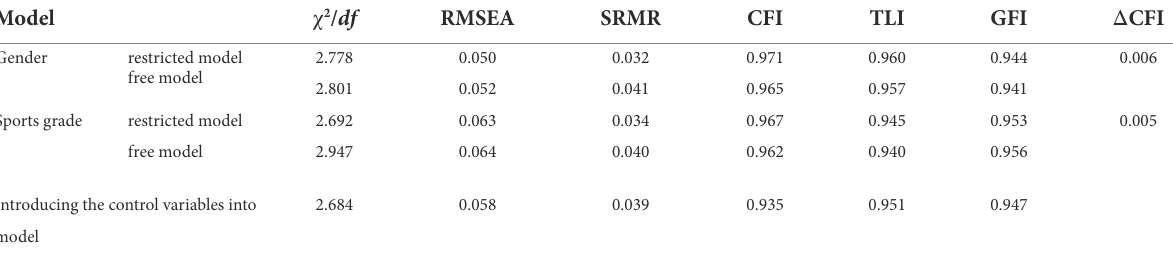
TABLE 4 Multi-group structural equation model fit